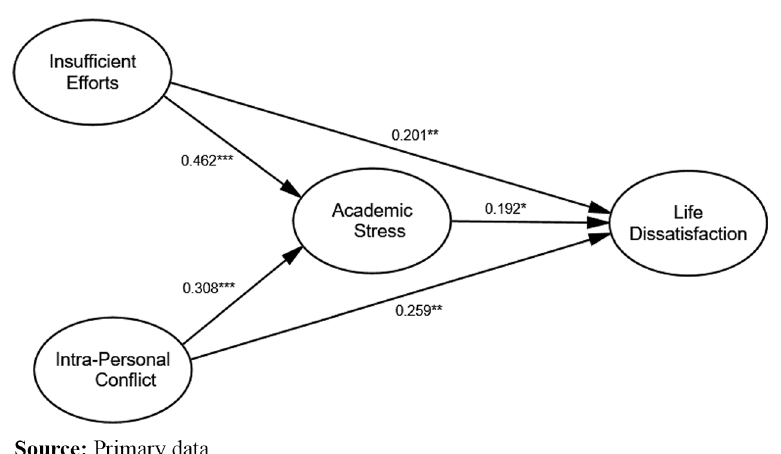
Figure 1. Hypothesized model